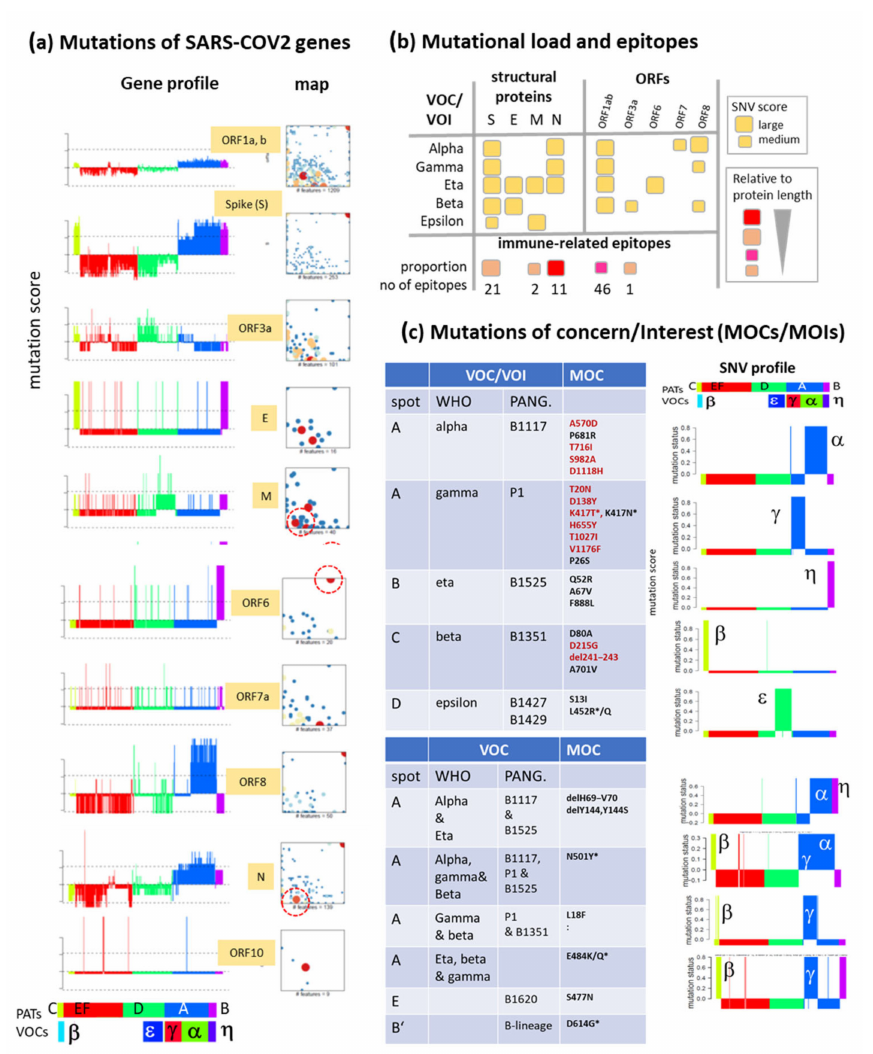
Figure 7. Mapping mutations. ( a ) SNVs from the SARS-CoV-2 genes are mapped into the SOM and depicted as SNV-score profiles sorted using PATs and VOCs/VOIs. Specifically increased mutational load is found for the different genes except ORF7a and 10. ( b ) Summary of the mutational load and of immunogenic epitopes of structural proteins and ORFs across the variant types as estimated using the SNV-score and data taken from [40], respectively. The spike and nucleocapsid proteins are most affected by SNV. VOI eta (PAT B) shows widest effect across the SARS-CoV-2 genome. Epitopes are enriched in N, S and orf1a/b. ( c ) Mutations of concern (MOC) were selected from https://covariants.org/ accessed on 17 July 2021 (Figure 5a). Spot location and VOC/VOI(s) showing the mutations (only S-gene) were listed. Part of SNVs appear either in one VOCs/VOIs (table above) or combinations of them (table below) as illustrated by their SNV-score profiles. Red text color marks high-confidence SNVs taken from [39] (Figure A8), asterisk marks MOCs as assigned in